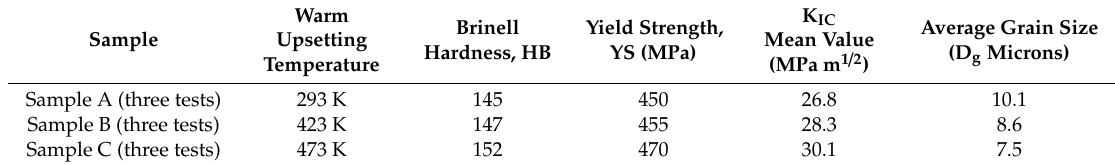
Figure 2. Warm upsetting temperature effect on the AA7050 alloy microstructure. ( a ) Warm upsetting temperature = 293 K, average D g = 10.1 μ m and ( b ) warm upsetting temperature = 473 K, average D g = 7.5 μ m (SEM-FEG images at 20 KX magnification). Table 3. Mechanical properties and mean grain size dependence on warm upsetting temperature in Alloy AA7050.